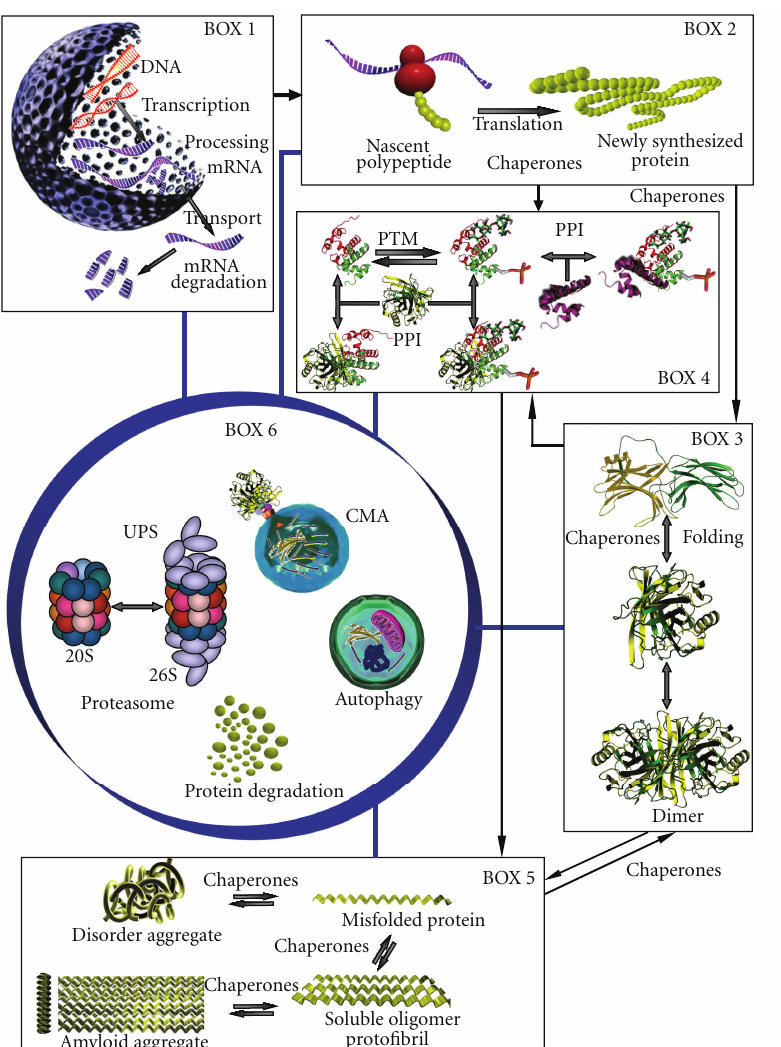
Figure 1: Schematic diagram of cell proteostasis. The boxes illustrate the di ff erent cellular process involved in protein homeostasis. BOX 1, nucleus, where gene transcription and pre-mRNA processing produce the mature mRNA that will be transported to the cytoplasm where it could be degraded (mRNA decay can also take place in the nucleus). The mRNA is engaged, mainly in the cytoplasm, to translation by the ribosomal machinery producing a nascent polypeptide that grows to a newly synthesized protein (BOX 2). The folding of the newly synthesized proteins, helped by chaperones, results in the “so-called” native protein structure either monomeric or oligomeric (BOX 3, only a dimer is shown for simplicity). Both the newly synthesized proteins and the mature mono or oligomeric forms of proteins are subjected to post-translational modification (PTM) and specific and unspecific protein-protein interactions (PPIs) that are illustrated in BOX 4. Proteins due to changes in its native conformation produced by di ff erent physical and/or chemical perturbations of the cell, or by mutations, could get misfolded or misprocessed and misfolded. The misfolded proteins, perhaps under the influence of PPIs and PTMs, will produce protein aggregates or soluble oligomeric protofibrils that eventually may form amyloid fibers (BOX 5). The degradation of proteins (BOX 6) is mainly due to the ubiquitin-proteasome System (UPS, nucleus and cytoplasm, 20S, and 26S proteasome) and the autophagic pathways (cytoplasmic): mainly chaperone-mediated authopagy (CMA) and macroautophagy (autophagy). Other proteases also participate in protein degradation (calpains, caspases, etc.), not shown. Blue lines connect all the boxes to the central circular box of protein degradation (BOX 6) indicating that proteolysis can regulate any of the process and vice versa. Black arrows connecting boxes indicate the “flow” of the products depicted in each